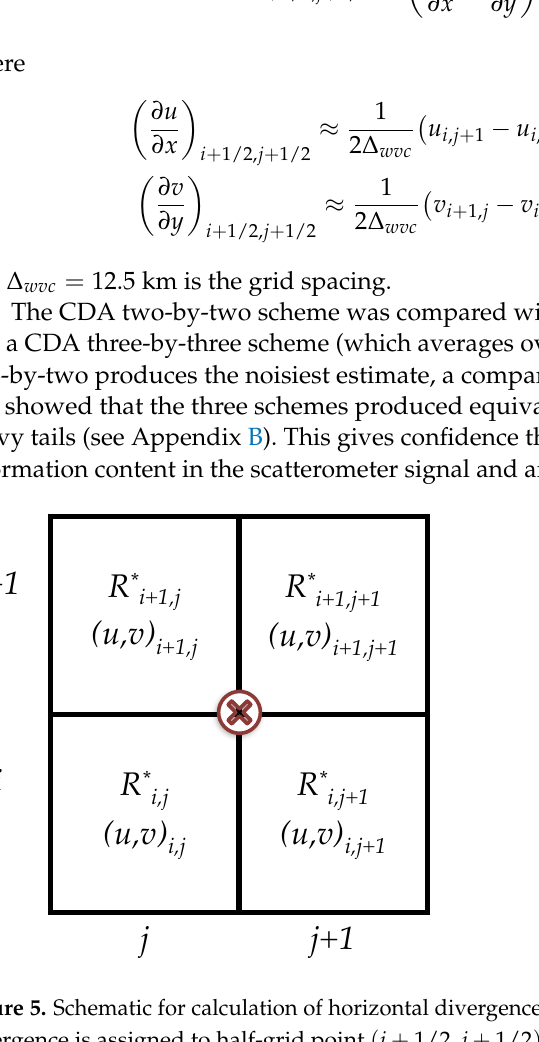
is maximum MSG rain rate in area i , j